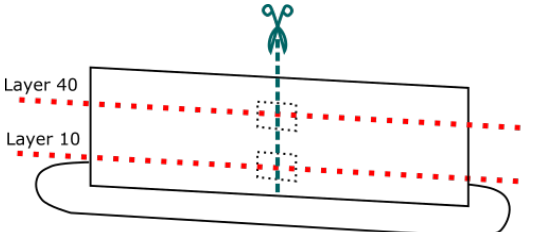
Figure 3. A schematic depiction of the methodology followed for sectioning of the printed wall geometries by cutting out rectangular specimens around the middle regions of layers 10 and 40, which will be subsequently sectioned perpendicular to the layer direction in the